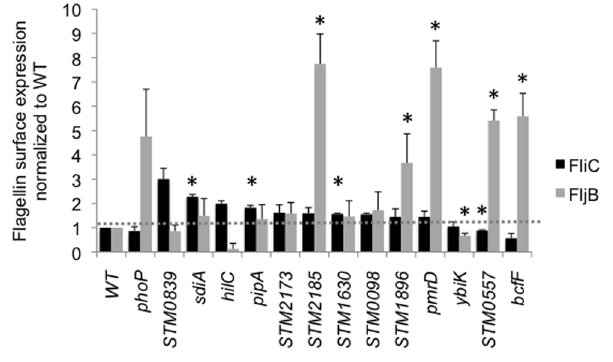
Figure 5. Elevated levels of flagellin were present on the bacterial surface of some mutants with improved swimming and swarming motility. Flagellins were sheared from bacterial surface, analyzed by Western blotting with antibodies to FliC and FljB and blots were quantified by densitometry using Quantity One software. Surface expression of flagellins was normalized to the level on the surface of the wild type strain. Samples for each mutant were prepared in three independent